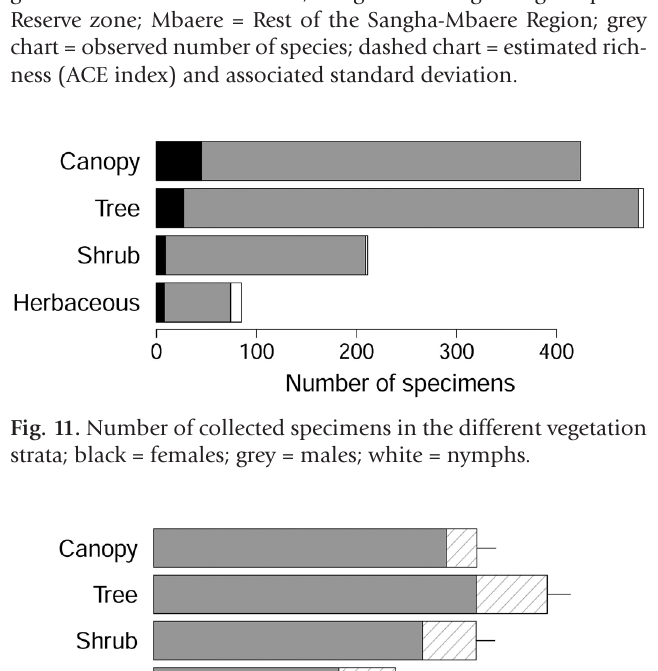
Fig. 9. Rarefaction curve of Mantodea from Sangha-Mbaere Re- gion (black curve) with an extrapolation in a hypothetical situa- tion where sampling effort would be doubled (dashed curve); grey area = confidence interval.